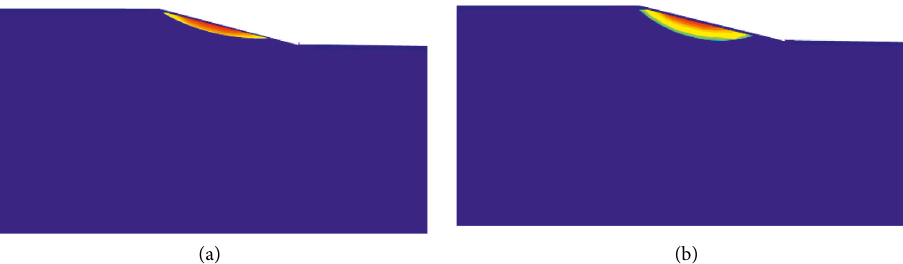
Figure 8: Stability analysis of potential sliding surface of slope. (a) Rain strength 38.8 mm/d. (b) Rain strength